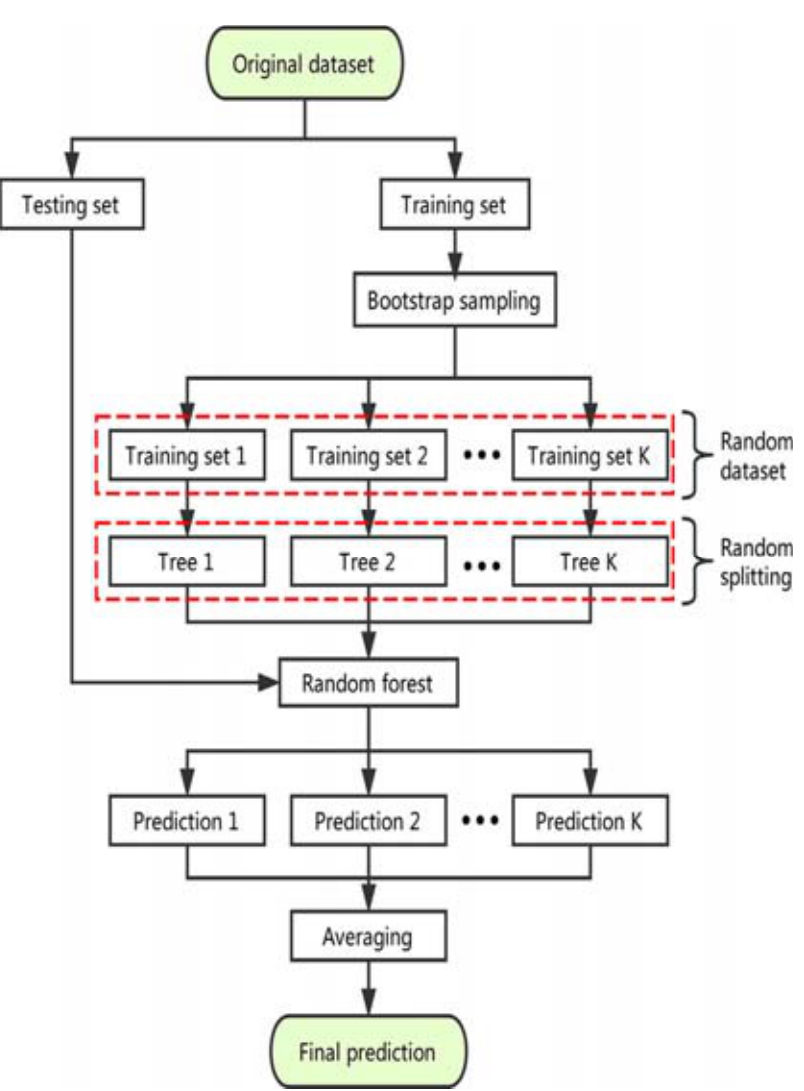
Figure 2. Schematic diagram of the random forest model (Reprinted with permission from [18]).